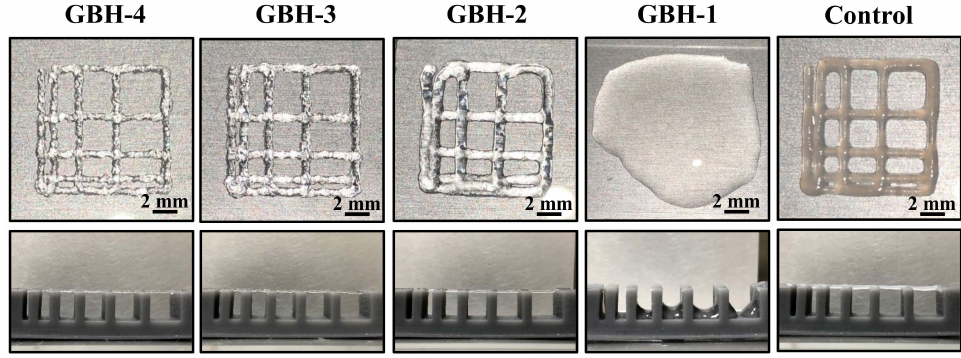
Figure 6. Filament fusion ( upper line) and collapse testing ( bottom line) results of the investigated